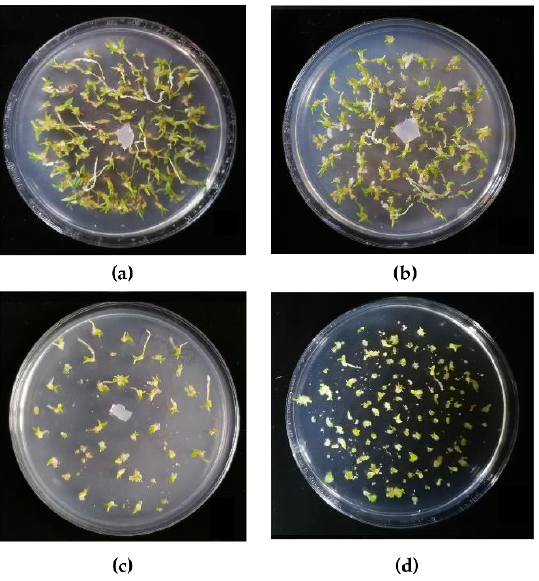
Figure 6. Morphology of the symbionts on day 90. ( a ) Strain T12 in Clade A; ( b ) Strain T9 in Clade B; ( c ) Strain T13 in Clade C; ( d ). Control. The Petri dishes are 9 cm in diameter.